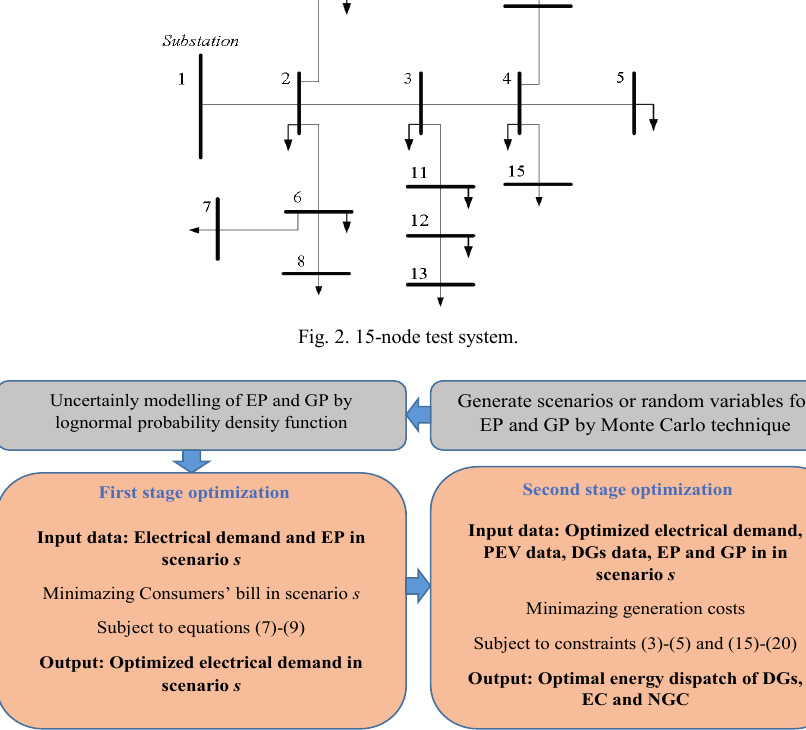
Fig. 3. Flowchart of the proposed